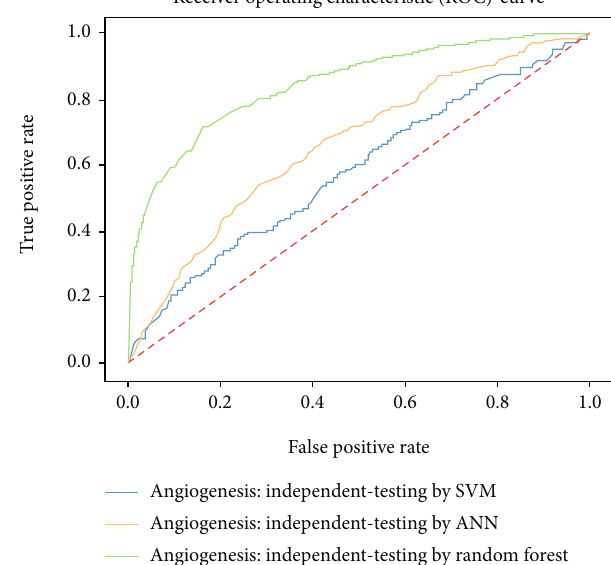
Figure 10: Independent testing comparison.